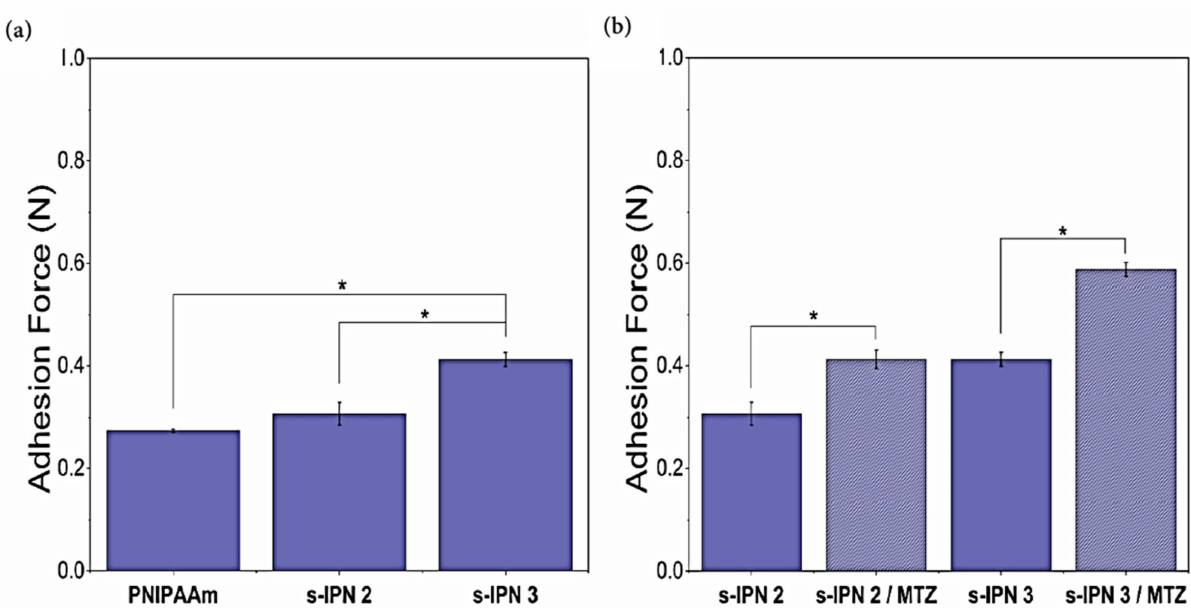
Figure 7. Cycles of swelling/shrinking of the neat PNIPAAm hydrogel and s-IPN samples, under alternating temperatures of 25/37 ◦ C. Error bars are included in the graphs.